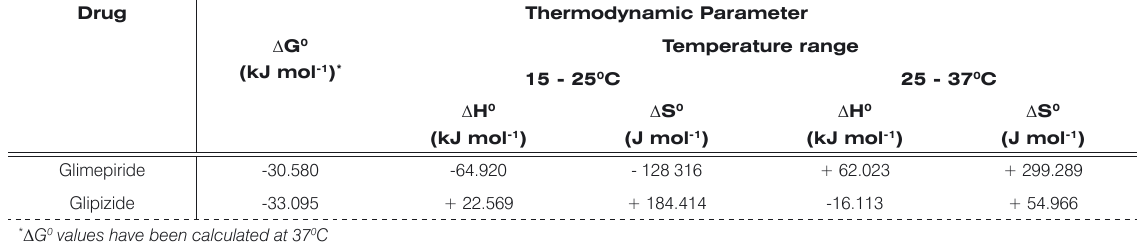
Table 3. Thermodynamic parameters for the binding of glimepiride and glipizide to HSA